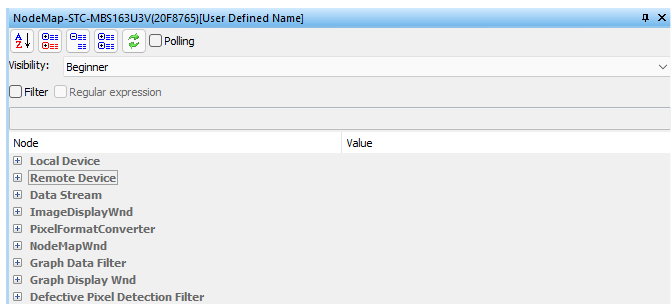
Figure 30. Available parameter categories.